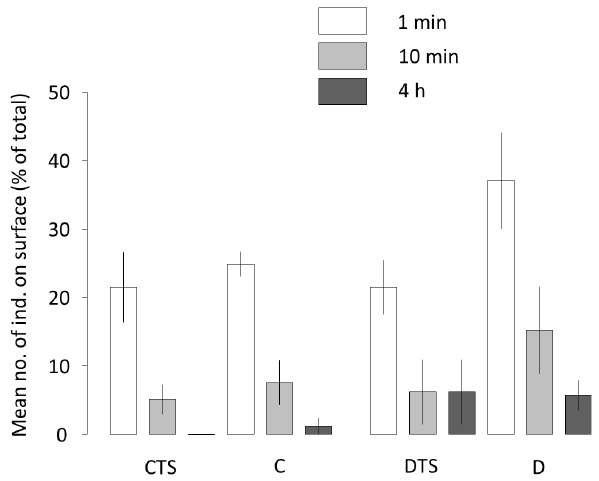
Fig. 3. Macomona liliana . Average number of post-settlement juve- Figure 3: Macomona liliana . Average number of post-­‐settlement juveniles (mean ± 1SD, n = niles (mean ± 1SD, n = 5) remaining on the sediment surface after 5) remaining on the sediment surface after 1 min, 10 min and 4 h after placement expressed 1min, 10min, and 4h after placement expressed as a percentage as a percentage of the total initially added (18–20 individuals). C, untreated intertidal of the total initially added (18–20 individuals). C: untreated inter- sediment; CTS, intertidal sediment covered with TS; and DTS, organic-­‐matter depleted tidal sediment; CTS: intertidal sediment covered with TS; and DTS: organic-matter depleted sediment covered with TS. sediment covered with TS